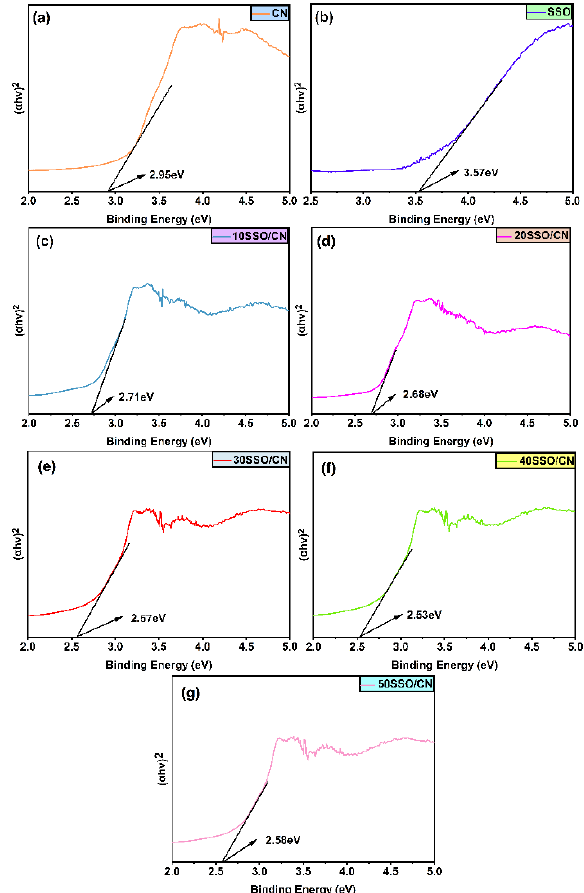
Figure 6. The DRS patterns of CN ( a ), SSO ( b ), 10SSO/CN ( c ), 20SSO/CN ( d ), 30SSO/CN ( e ),